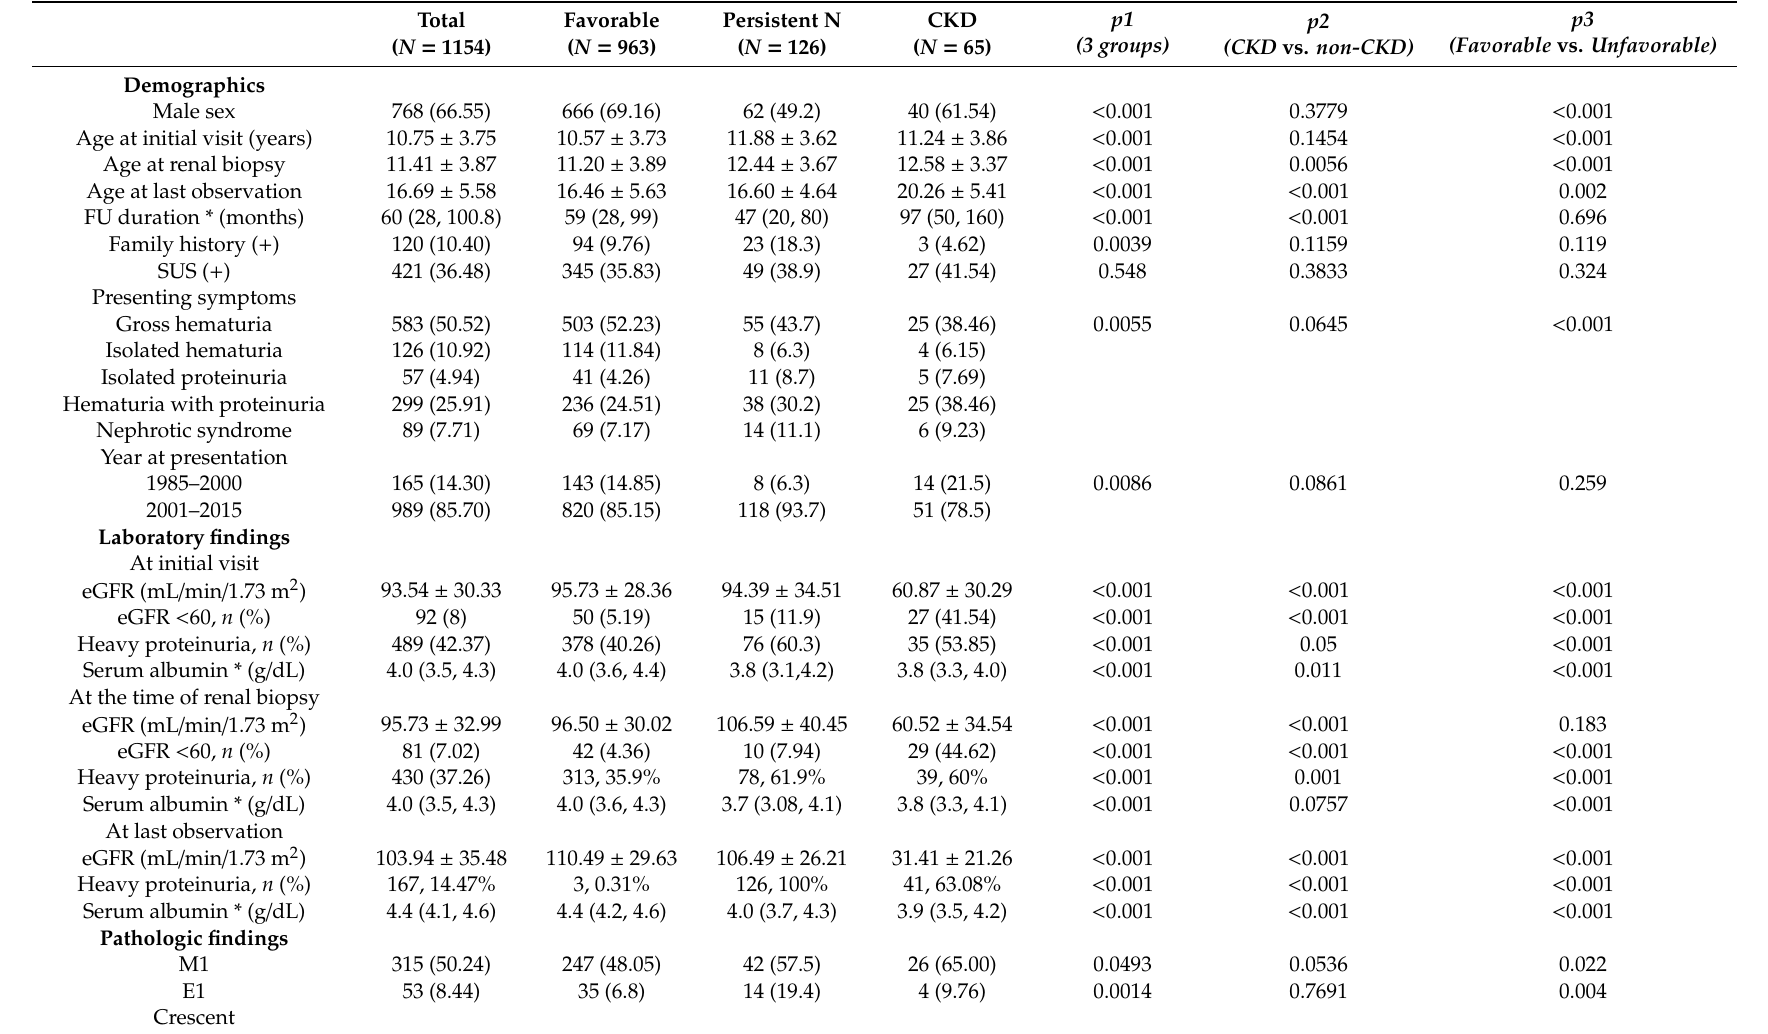
Table 1. Comparisons of clinical, laboratory, and pathological parameters according to final